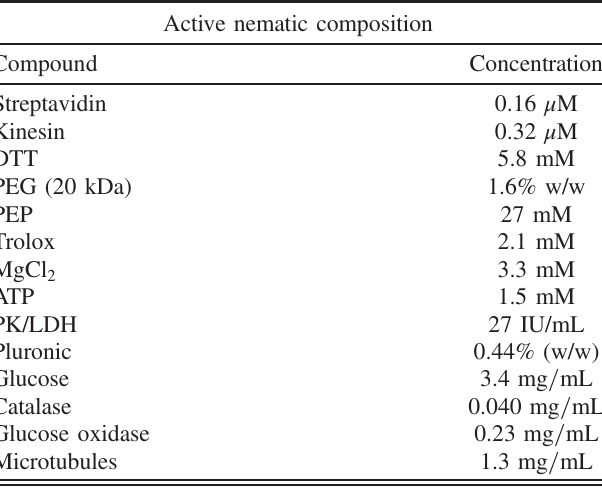
TABLE I. Composition of the active nematic. (Definitions of acronyms found in